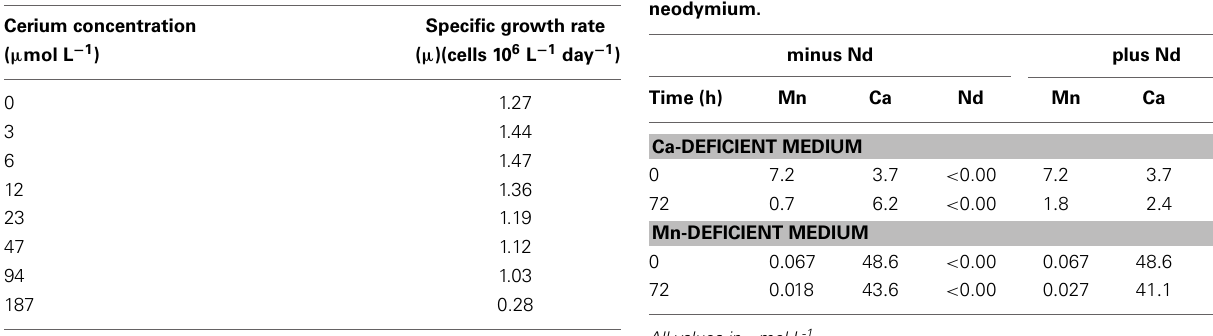
Table 3 | The effect of cerium concentration on specific growth rates of cultures of Desmodesmus quadricauda .